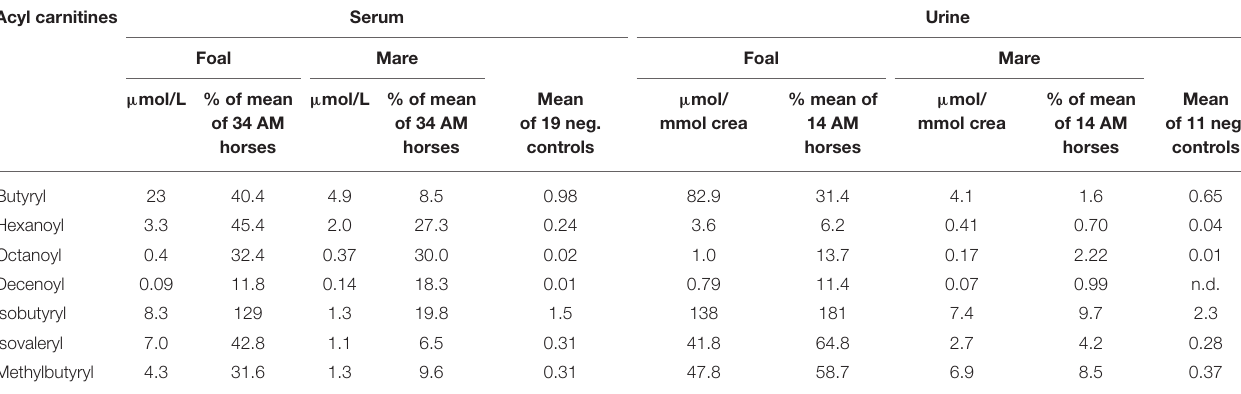
TABLE 2 | Concentrations of acylcarnitines found in serum and urine of the foal and the mare.